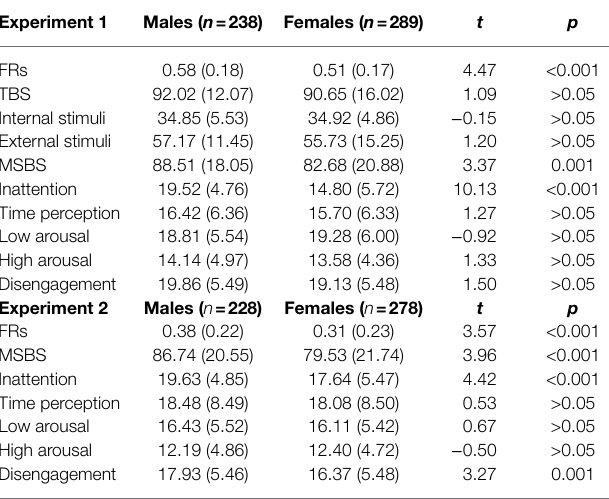
TABLE 2 | Descriptive statistics and gender differences for MSBS scores, TBS and FRs of participants. Experiment